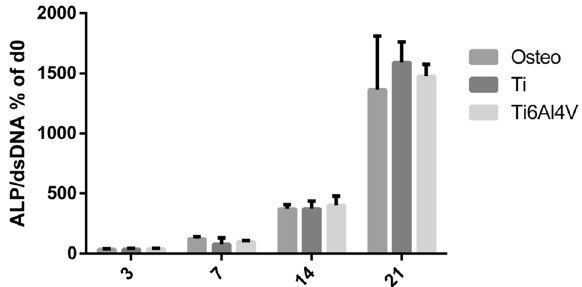
Figure 6. Effect of stimulation with Ti and Ti6Al4V alloy extracts upon ALP activity in cultured human bone marrow-derived mesenchymal stem cells (BM-MSCs). Statistically significant differences ( p < 0.05) are represented with * when comparison was made versus TCP and with the symbol # when comparison was made versus